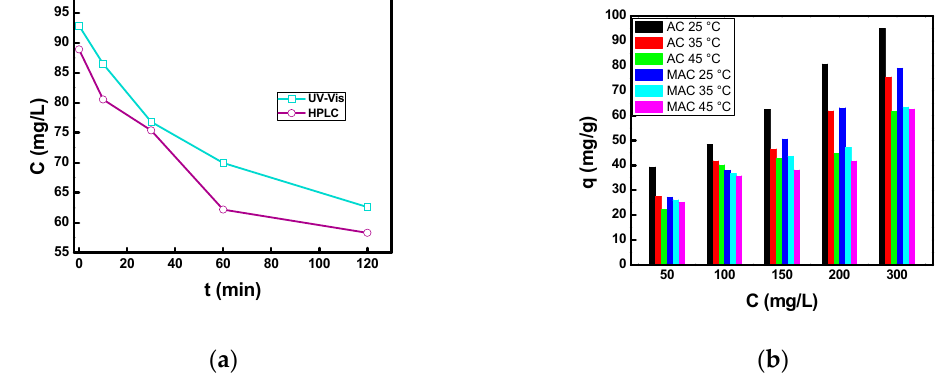
Figure 4. ( a ) Comparison between UV–vis and HPLC techniques in the adsorption of 2,4-D in AC at 25 °C; ( b ) Effect of initial concentration and temperature on the adsorption capacity.